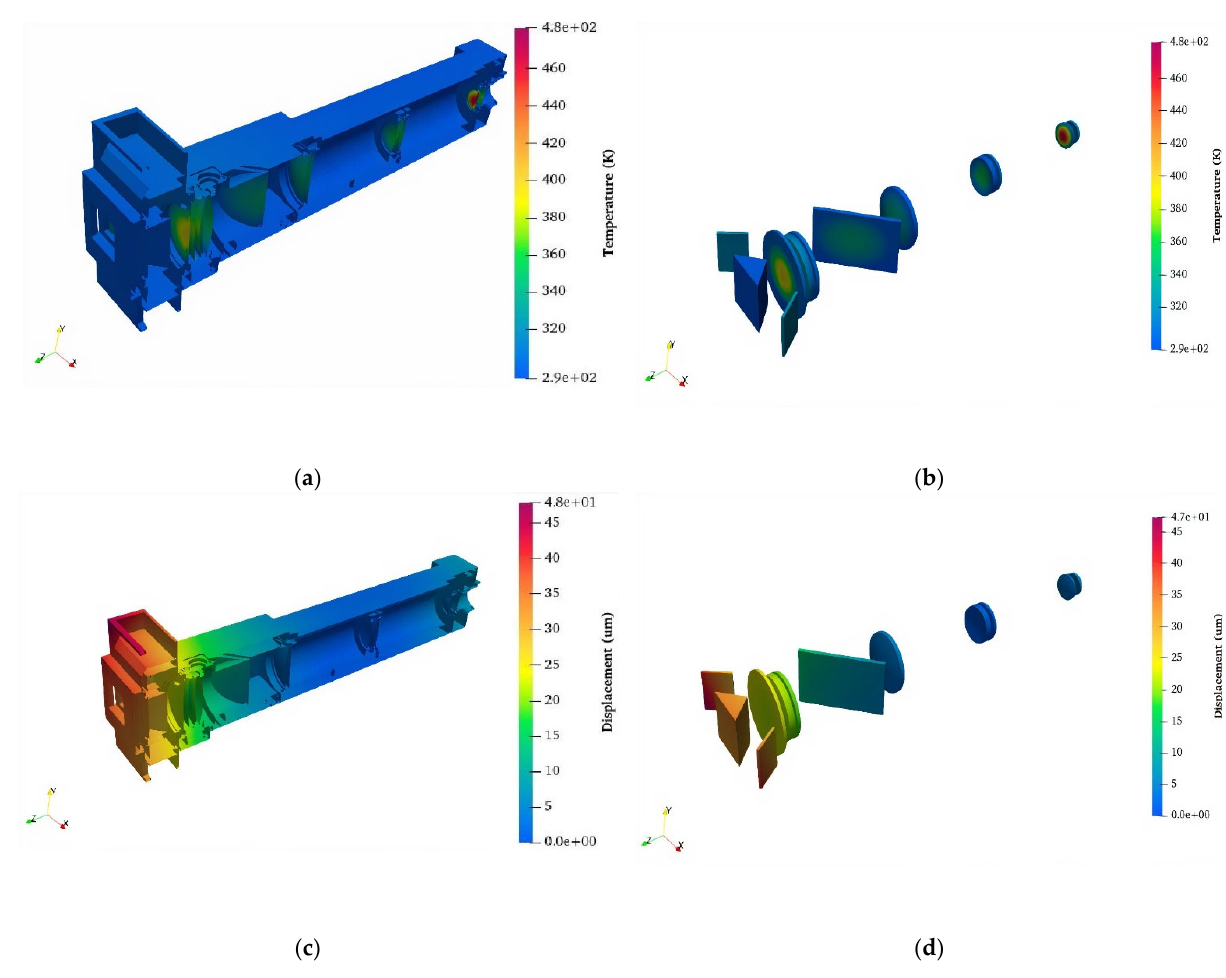
Figure 5. Temperature distributions by 1.634 kW in ( a ) housing structure and ( b ) lenses, and deformation distributions in ( c ) housing structure and ( d ) lenses.